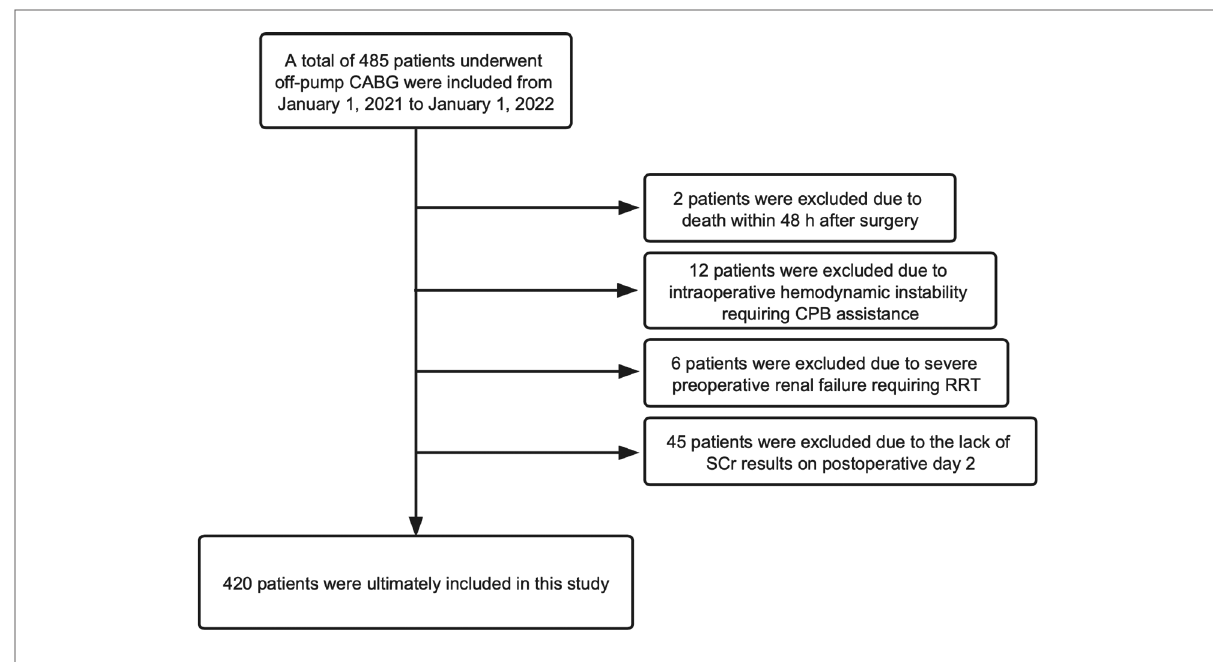
FIGURE 1 Flowchart of our